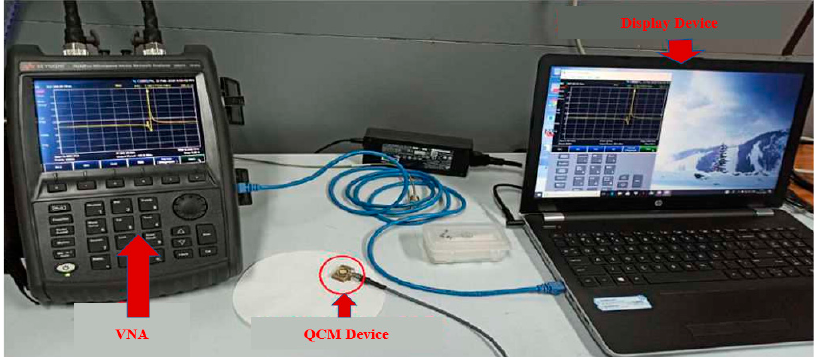
Figure 7. Microfluidic experimental platform for the selective detection of Hg 2+ ions by a VNA-based QCM sensor [95].